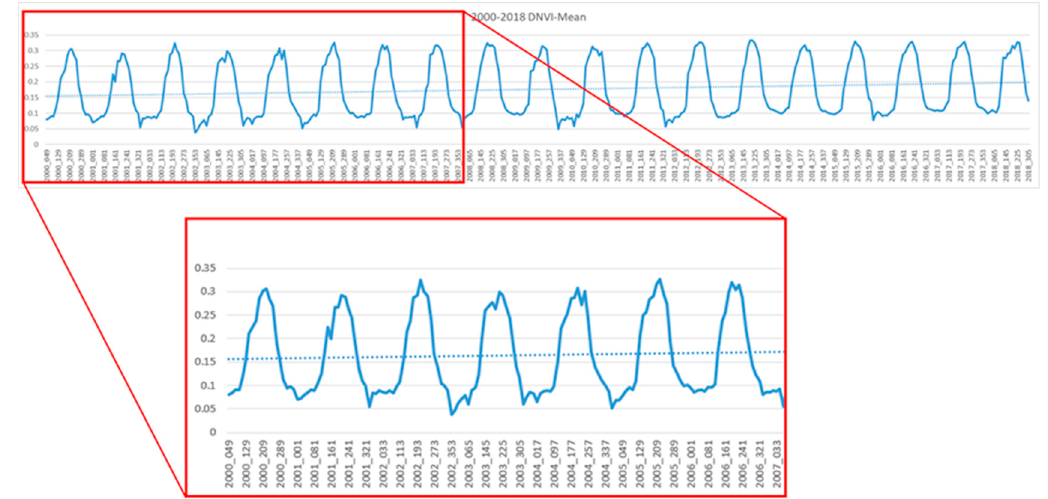
Figure 2. Mean NDVI of Mount Wutai from 2000 to 2018 based on MODIS.